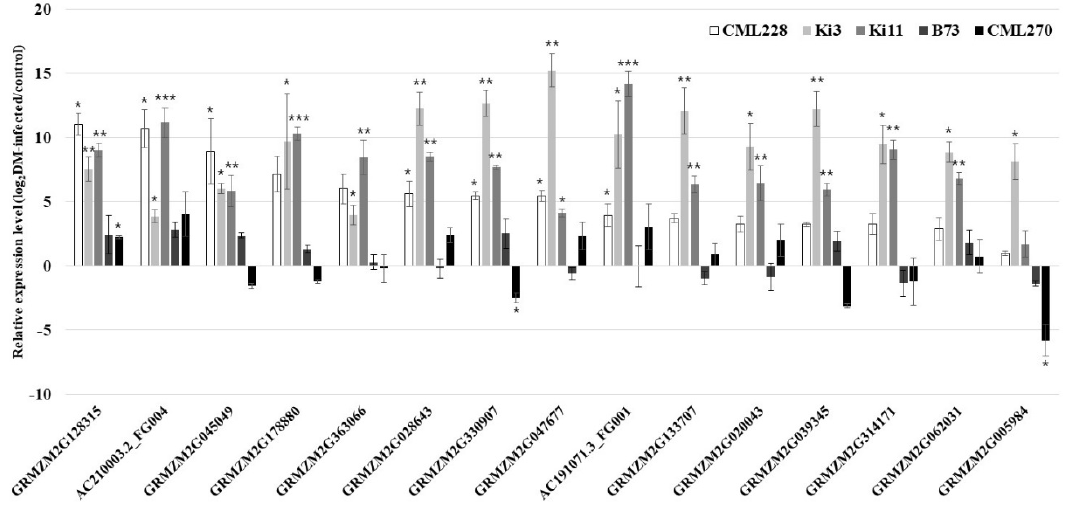
Figure 4. Relative expression levels (log 2 DM-infected / control) of 15 candidate genes for P. sorghi , P. maydis , and S. macrospora via qRT-PCR in the control and infected plants. The analysis was conducted on three independent plants as biological replicates. The data are presented as the mean ± SE values. Student’s t -tests were carried out in the statistical analysis (* p < 0.05; ** p < 0.01; *** p < 0.001).